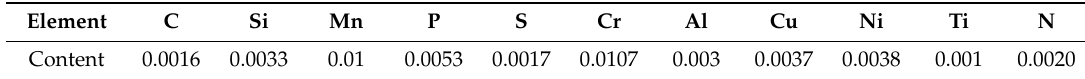
Table 1. Chemical compositions of mother steel (weight